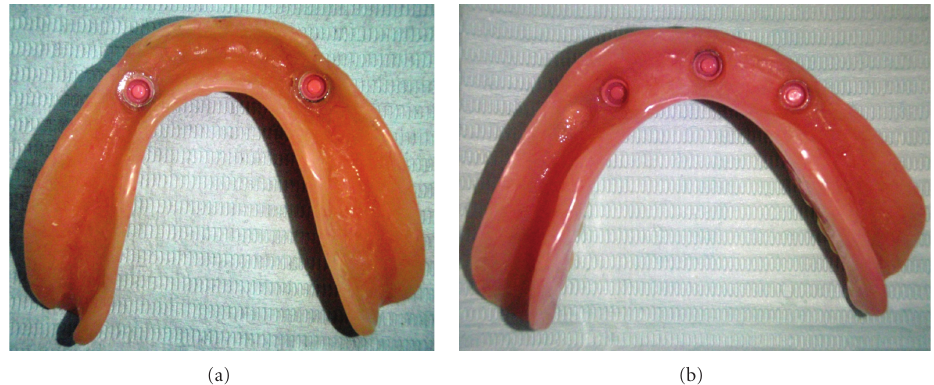
Figure 3: Finished mandibular overdentures with pink replacement males immediately before